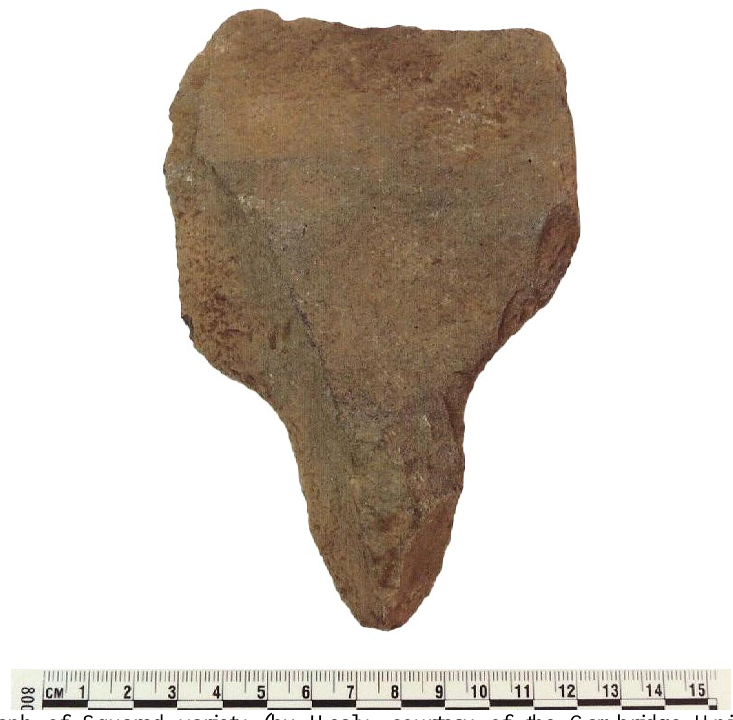
Figure 5. Photograph of Squared variety (by Healy, courtesy of the Cambridge University Museum of Archaeology and Anthropology, Cat. No. Z35258B; scale in